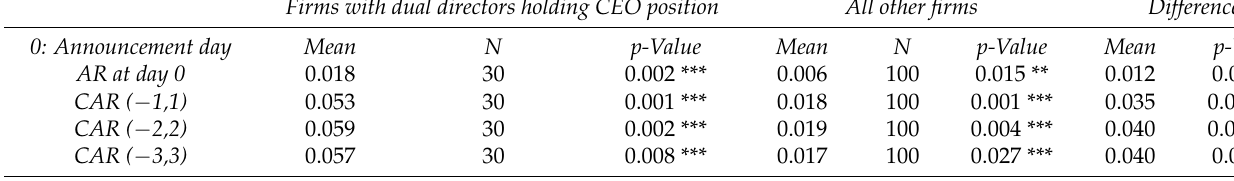
Firms with dual directors holding CEO